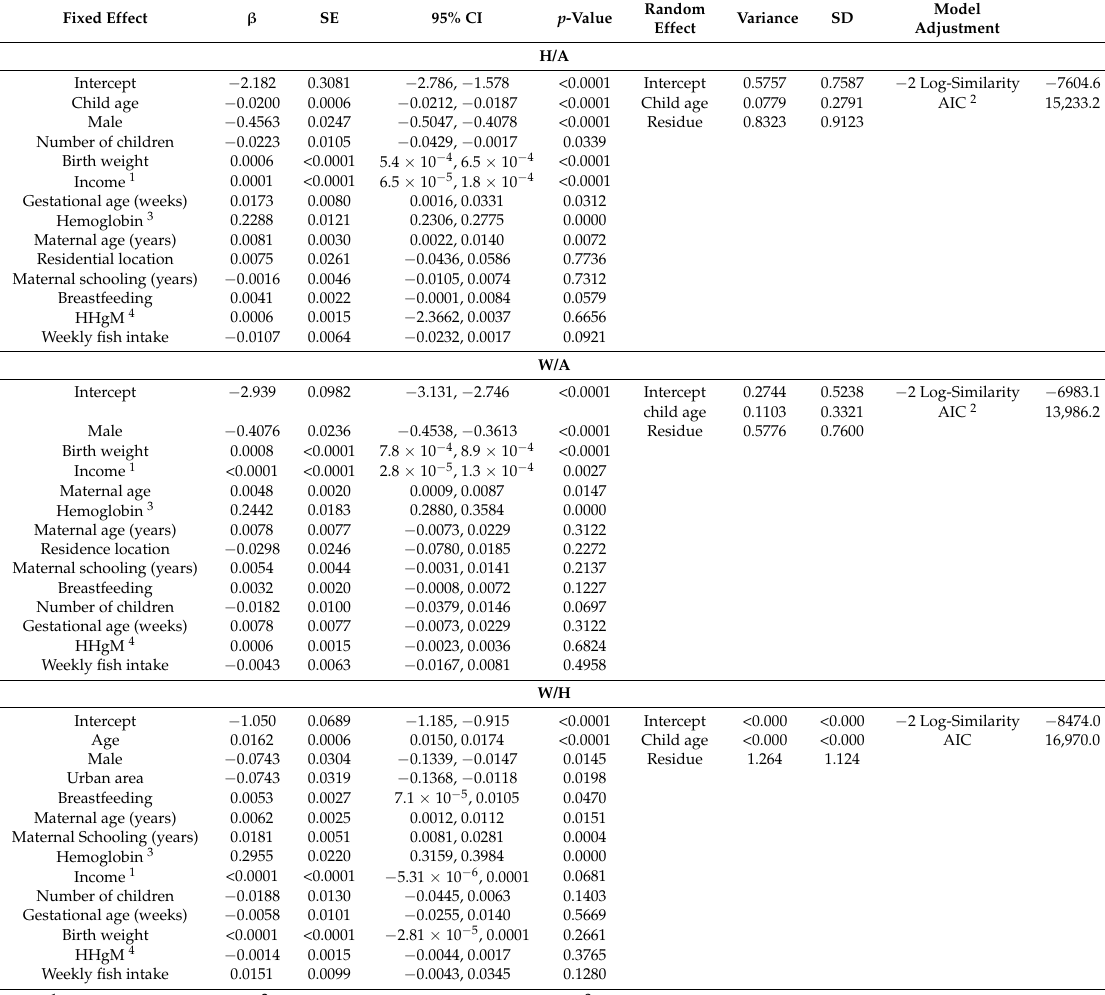
Table 2. Multiple analyses of the linear mixed-effect model with random intercept and slope for H/A, W/A, and W/H indices in children from Rond ô nia State,